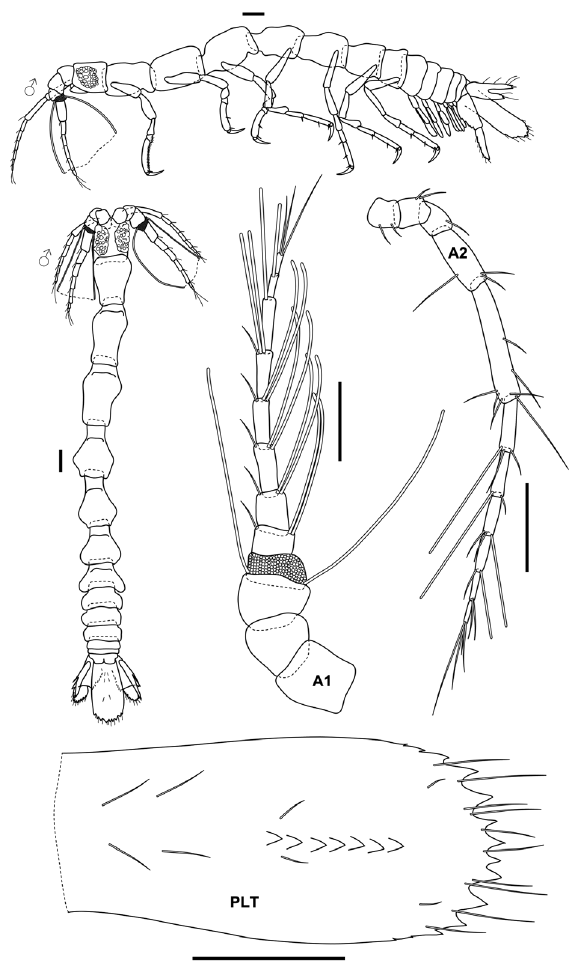
Fig ure 3. Eisothistos tiomanensis sp. n. All scales represent 0.1 mm.